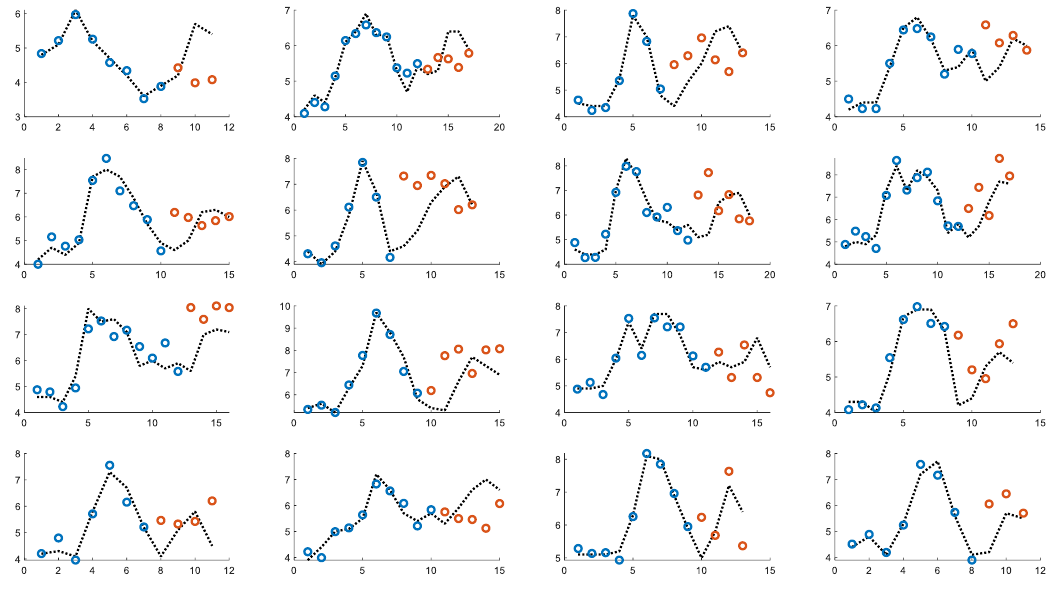
Fig.9: PLS model with three components based on NIR, resistance and reactance. Individually trained until the start of intake of sugar-containing soft drink for the second time (blue dots) and thereafter used for prediction (orange dots).